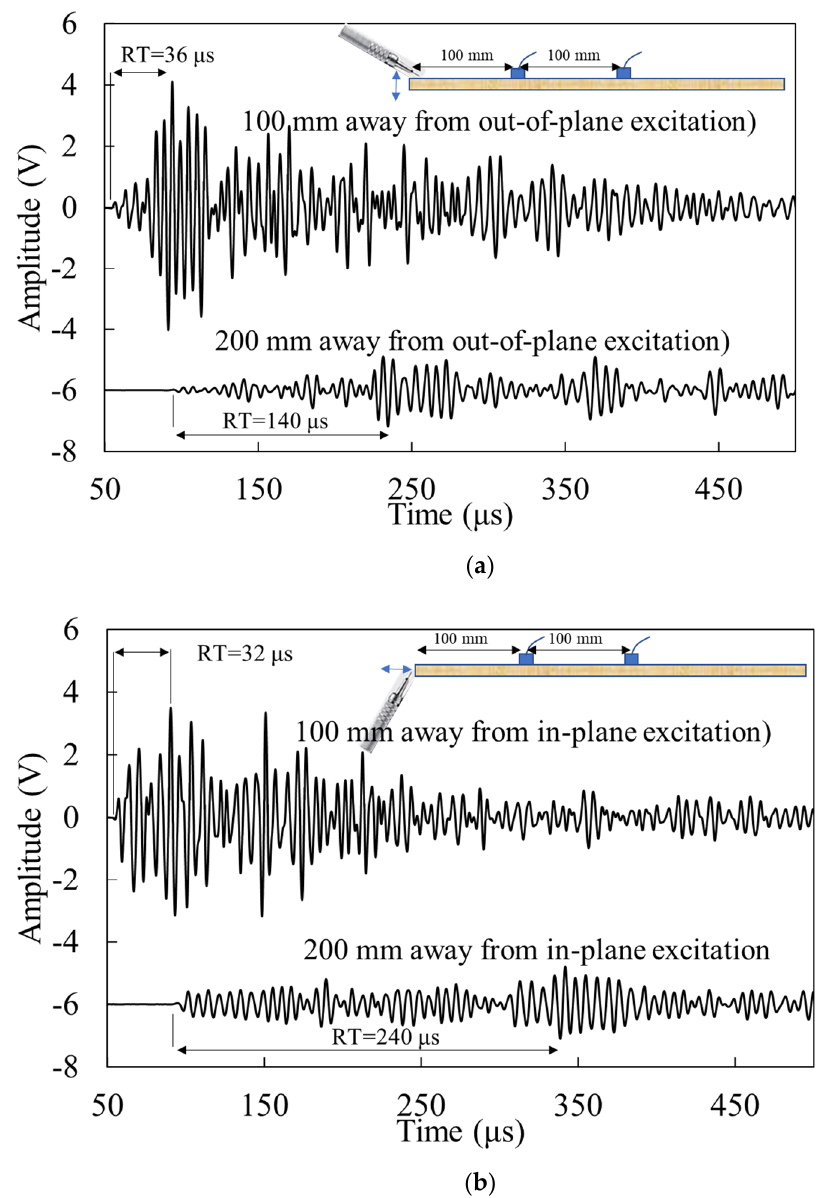
Figure 5. Waveforms from sensors at different distances from pencil lead excitation on the TRC plate: ( a ) out-of-plane excitation and ( b ) in-plane excitation. The arrow in front of the plate denotes the direction of the excitation. The amplitude values of the second sensor are shifted downward for clarity.